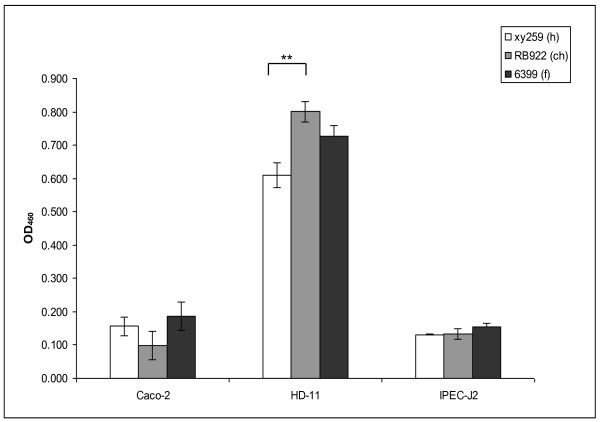
Phenotypic difference in adherence of three ST-21 C. jejuni strains from human, animal and food source to mammalian cells. Human colonic epithelial cells (CaCo-2), chicken macrophage-like cells (HD-11) and porcine intestinal epithelial cells (IPEC-J2) were infected in triplicates with biotin-labelled bacteria at an MOI of 200 and coincubated for 1 h (Methods). Each bar represents the mean ± standard deviation number of adherent bacteria of one C. jejuni strain from triplicate measurement in one representative experiment. Statistical differences in adherence were evaluated using a Student's t test. A p value of < 0.05 was considered statistically significant (* p ≤ 0.05, ** p ≤ 0.01, *** p ≤ 0.001). h = human, ch = chicken, f = food.